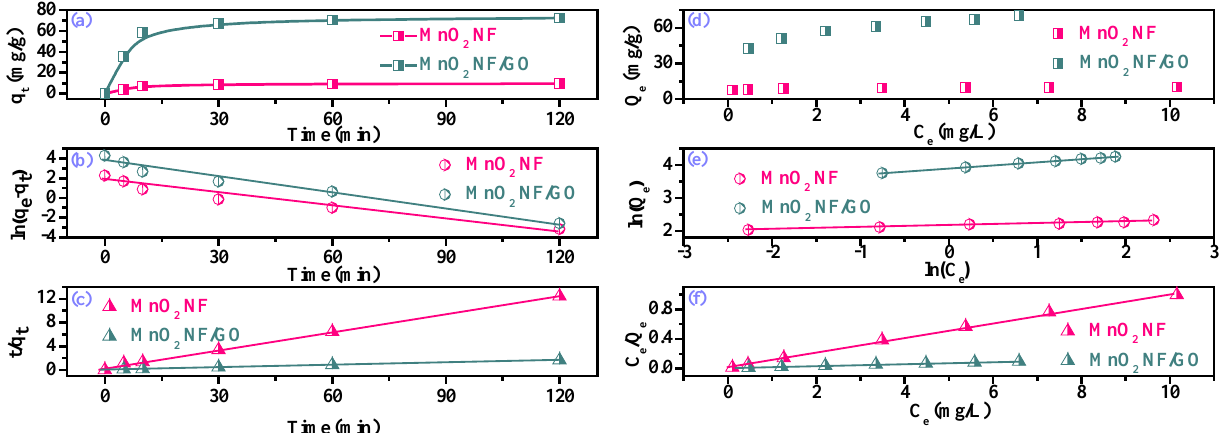
Figure 4. Effect of contact time for BbFA adsorption on as-synthesized composites ( a ); the linear plots of the pseudo-first-order model ( b ) and the pseudo-second-order model ( c ); effect of initial concentration for BbFA adsorption on the as-synthesized composites ( d ); the linear plots of Langmuir isotherm ( e ) and Freundlich isotherm ( f ). (dosage = 0.2 g/L, contact time = 2 h; temperature = 25 ± 1 ℃ ). Table 2. Parameters of kinetics models for the BbFA adsorption by as-synthesized composites.